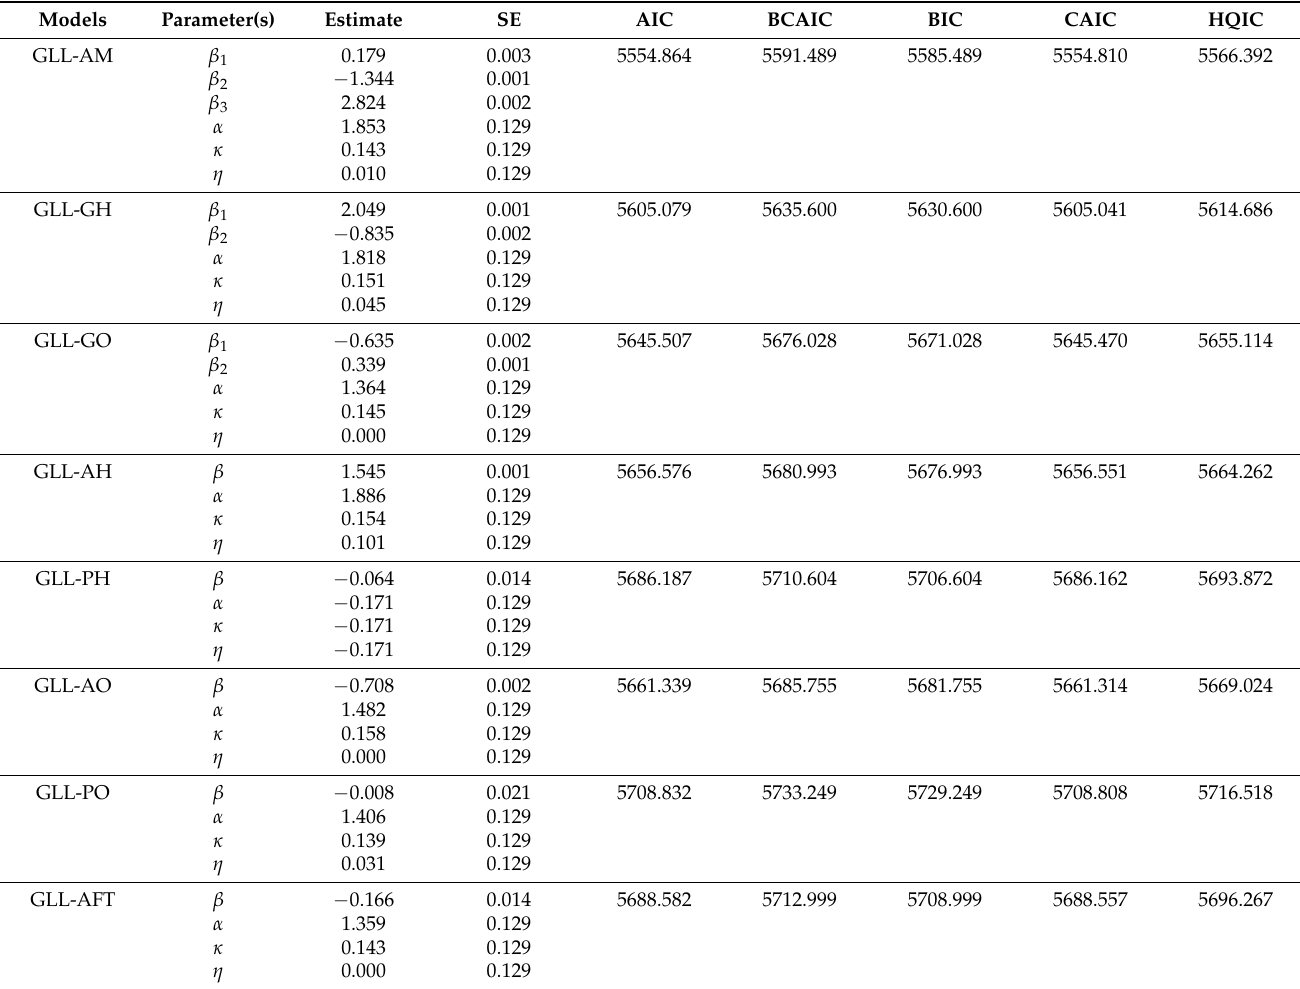
Table 4. Results from the fitted proposed fully-parametric odds-based and hazard-based regression models with GLL baseline distribution to IPASS